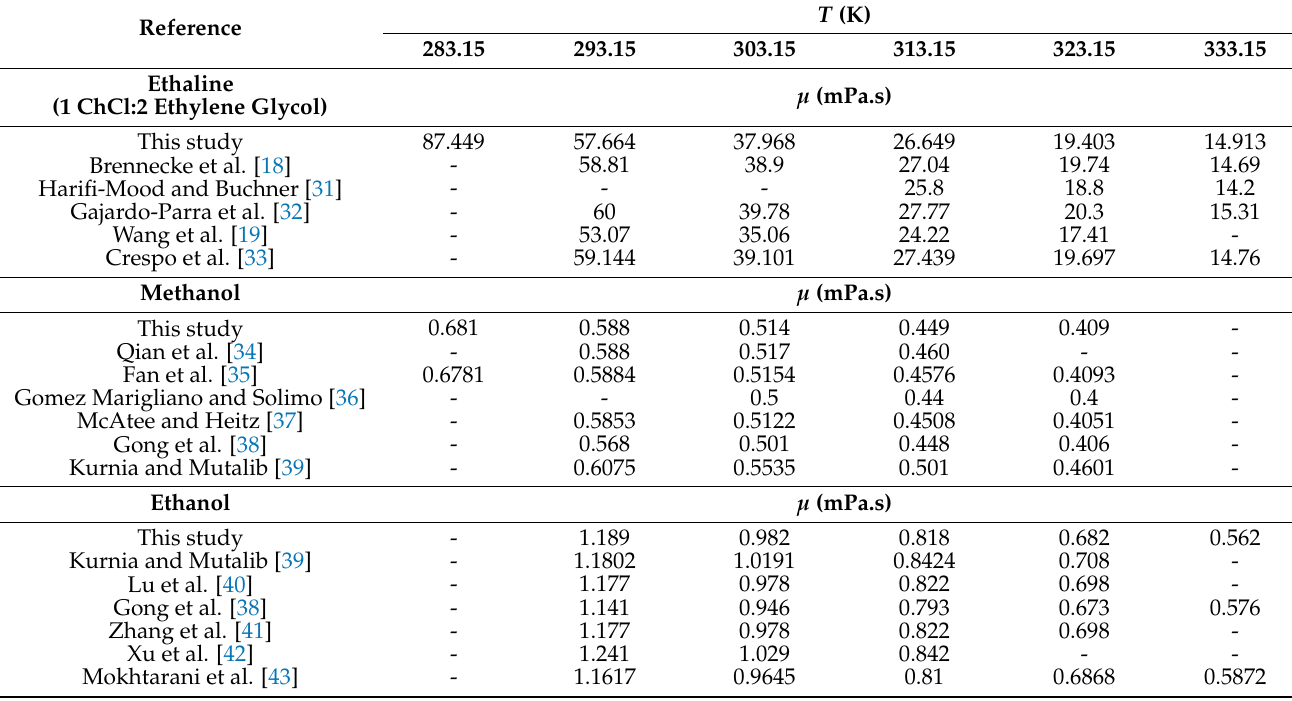
Table 2. Comparison of experimental values of viscosities for Ethaline, methanol, and ethanol in this study with literature values at atmospheric pressure a,b,c .